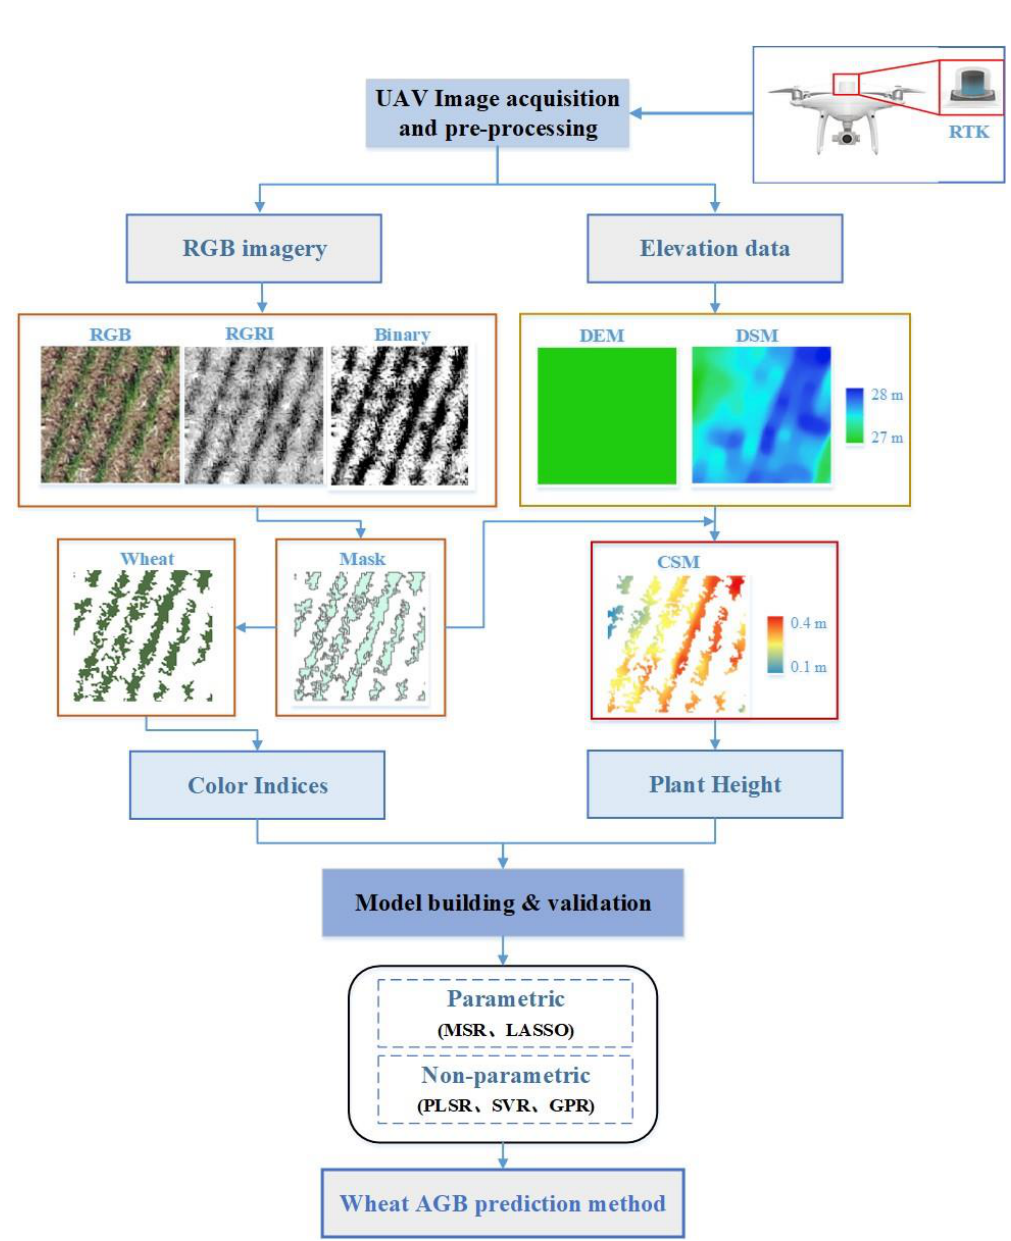
Figure 2. The main process of this study.